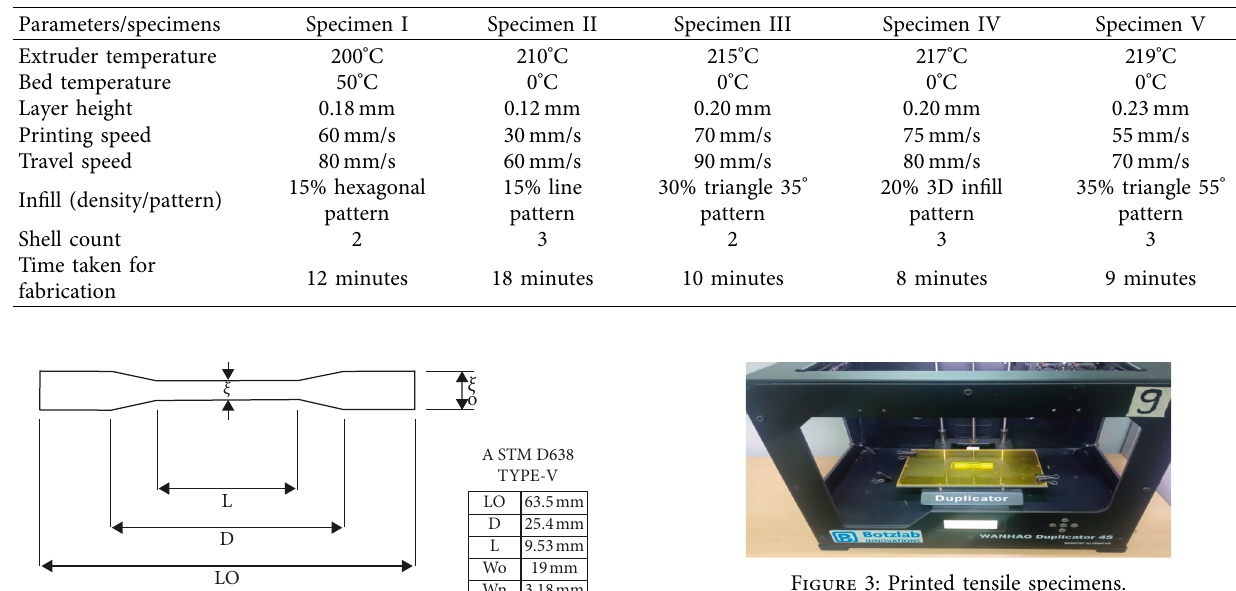
Table 1: Printing parameters of specimens.